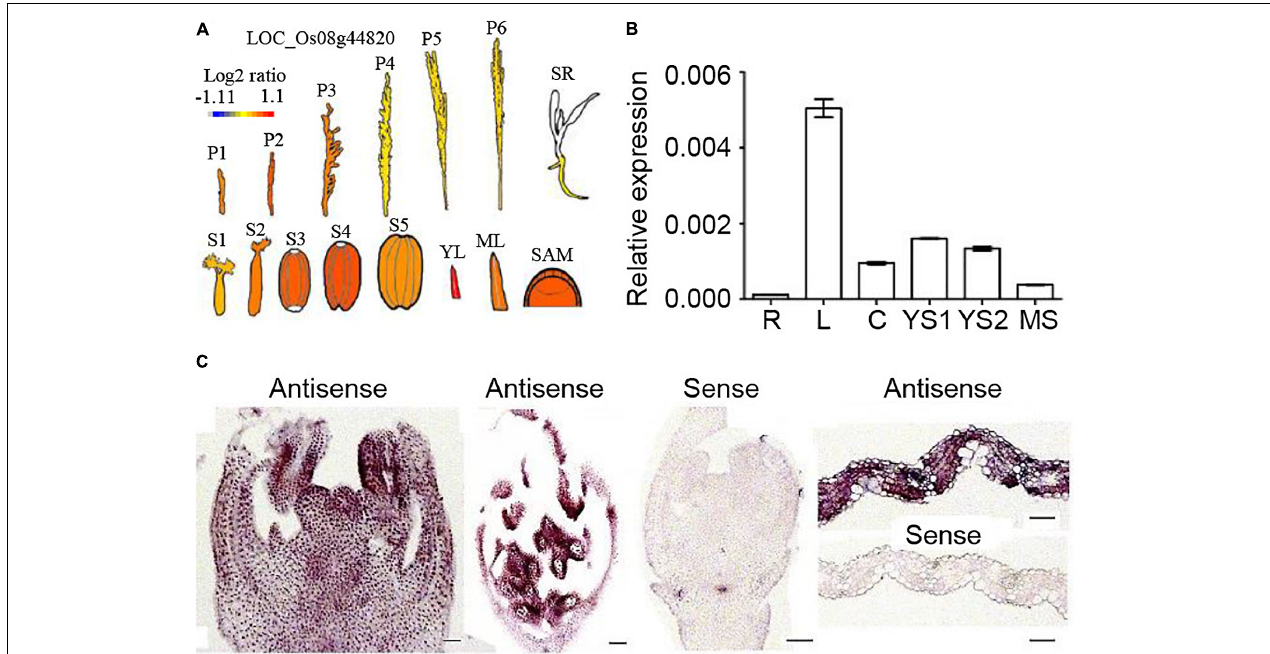
FIGURE 3 | Expression patterns of OsNTL5 . (A) Relative expression levels of OsNTL5 in inflorescences, seedlings, seeds, young leaves, mature leaves and SAM based on microarray data showed in the eFP browser (http://www.bar.utoronto.ca/efp/cgi-bin/efpWeb.cgi). The color scale shows microarray signal level. P1, Young Inflorescence (P1); P2, Inflorescence (P2); P3, Inflorescence (P3); P4, Inflorescence (P4); P5, Inflorescence (P5); P6, Inflorescence (P6); SR, Seedling Root; S1-5, Seed S1-5; YL, Young Leaf; ML, Mature Leaf; SAM, Shoot Apical Meristem. (B) Relative expression of OsNTL5 in roots (R), leaves (L), culms (C), young